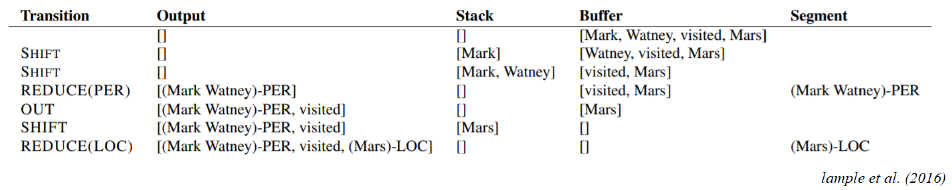
Figure 2. Example of transition based sequence applied on NER.